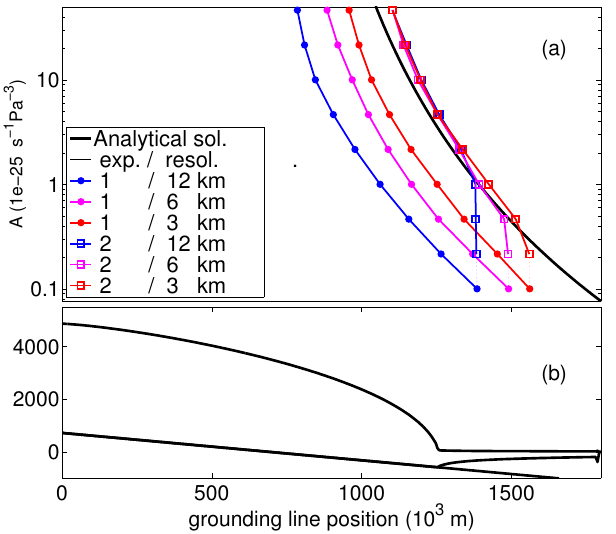
Fig. 6: Grounding-line position vs. resolution for experiment 1, step 1 of MISMIP. Green: with sub- Fig. 6. Grounding-line position vs. resolution for experiment 1, step Fig. 5: MISMIP experiments on a constant slope bed. (a) Dependence of grounding-line position Fig. 5. MISMIP experiments on a constant slope bed. (a) Depen- grid treatment of the calving front motion, blue: without. Black line: semi-analytical prediction. 1 of MISMIP. Green: with sub-grid treatment of the calving front on rate factor A . Solid black line: semi-analytical prediction. Colored lines: simulation results with dence of grounding-line position on rate factor A . Solid black line: motion, blue: without. Black line: semi-analytical semi-analytical prediction. Colored lines: simulation results with PISM-PIK, at ∆ x =12 , 6, 3km resolution. (b) Example ice sheet profile. PISM-PIK, at 1x = 12, 6, 3km resolution. (b) Example ice sheet profile.